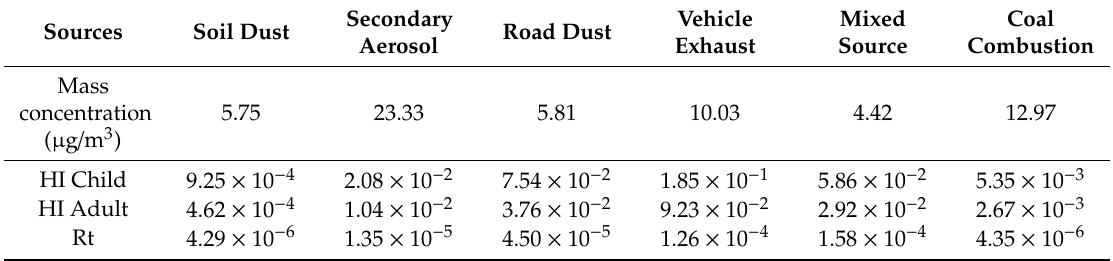
Table 5. Annual mass, risk index HI, and carcinogenic risk Rt of six identified sources of PM 2.5 .